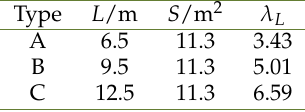
Table 1. Nose-slenderness ratio of three train calculation